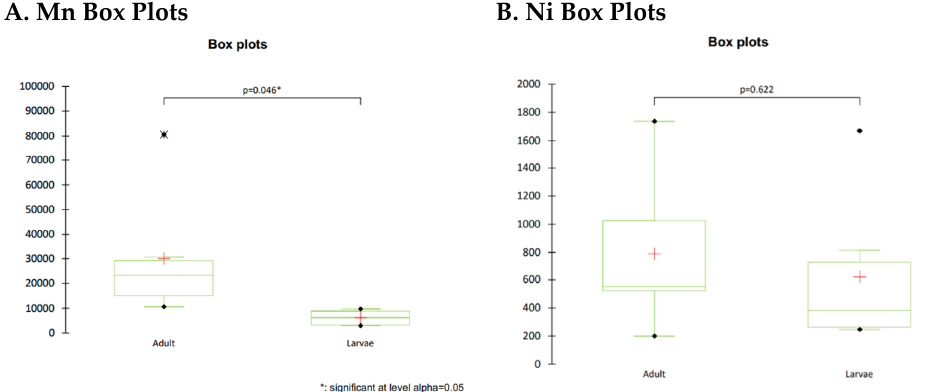
Figure 1. Exemplary box plots for Mn ( A ) and Ni ( B ), comparing adult bees with larvae.